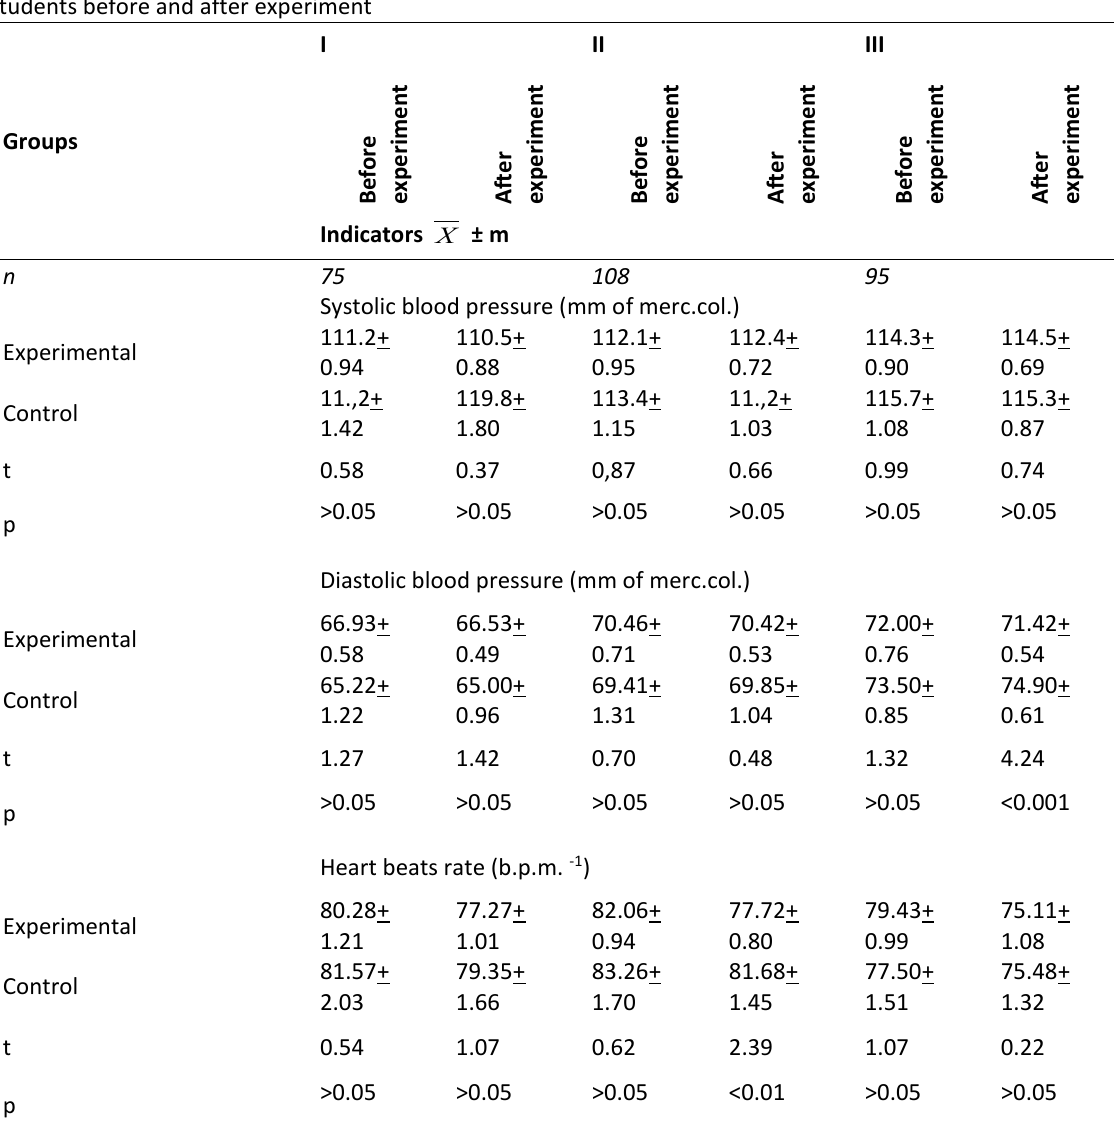
Table 3. Indicators of cardio-vascular system’s functional state of experimental and control groups’ girl students before and after experiment